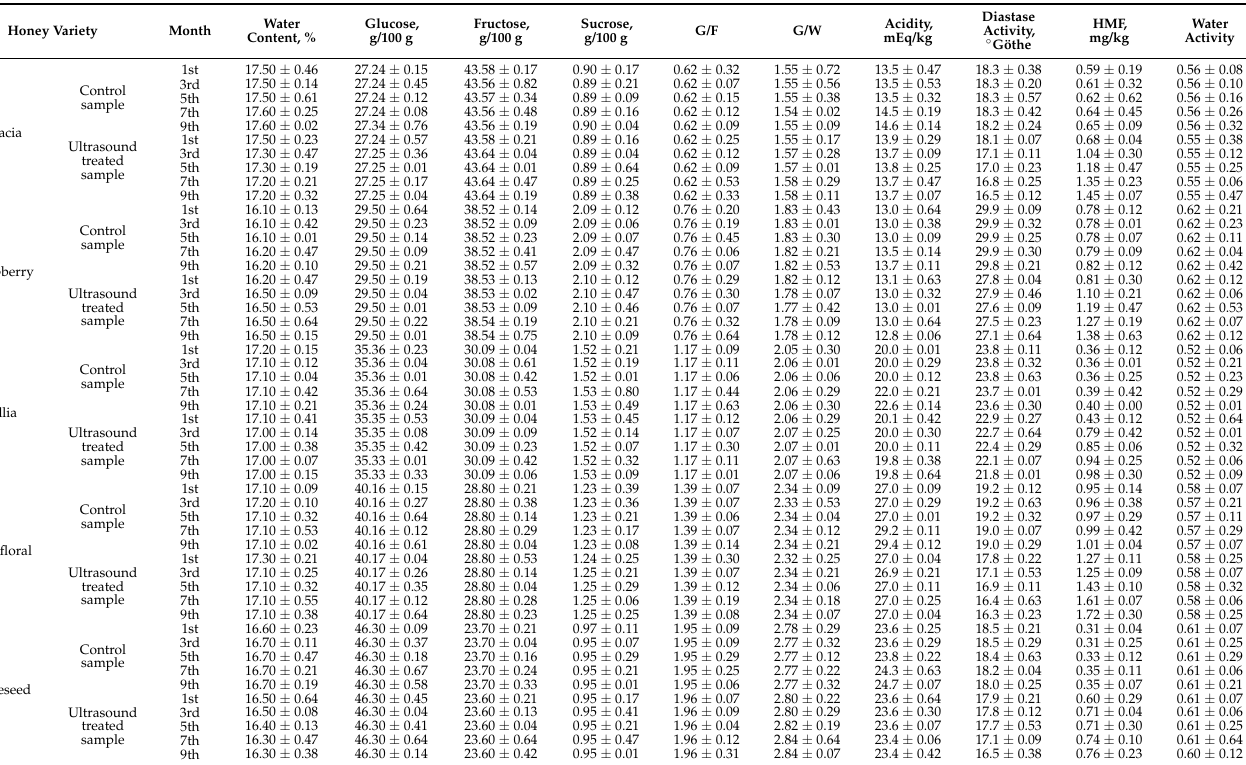
Table 1. Physicochemical analysis of honey